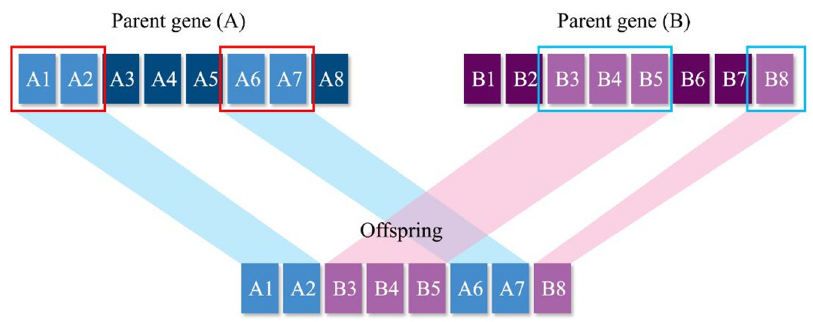
Figure 3. Multi-point crossover. Figure 3. Multi ‐ point crossover.